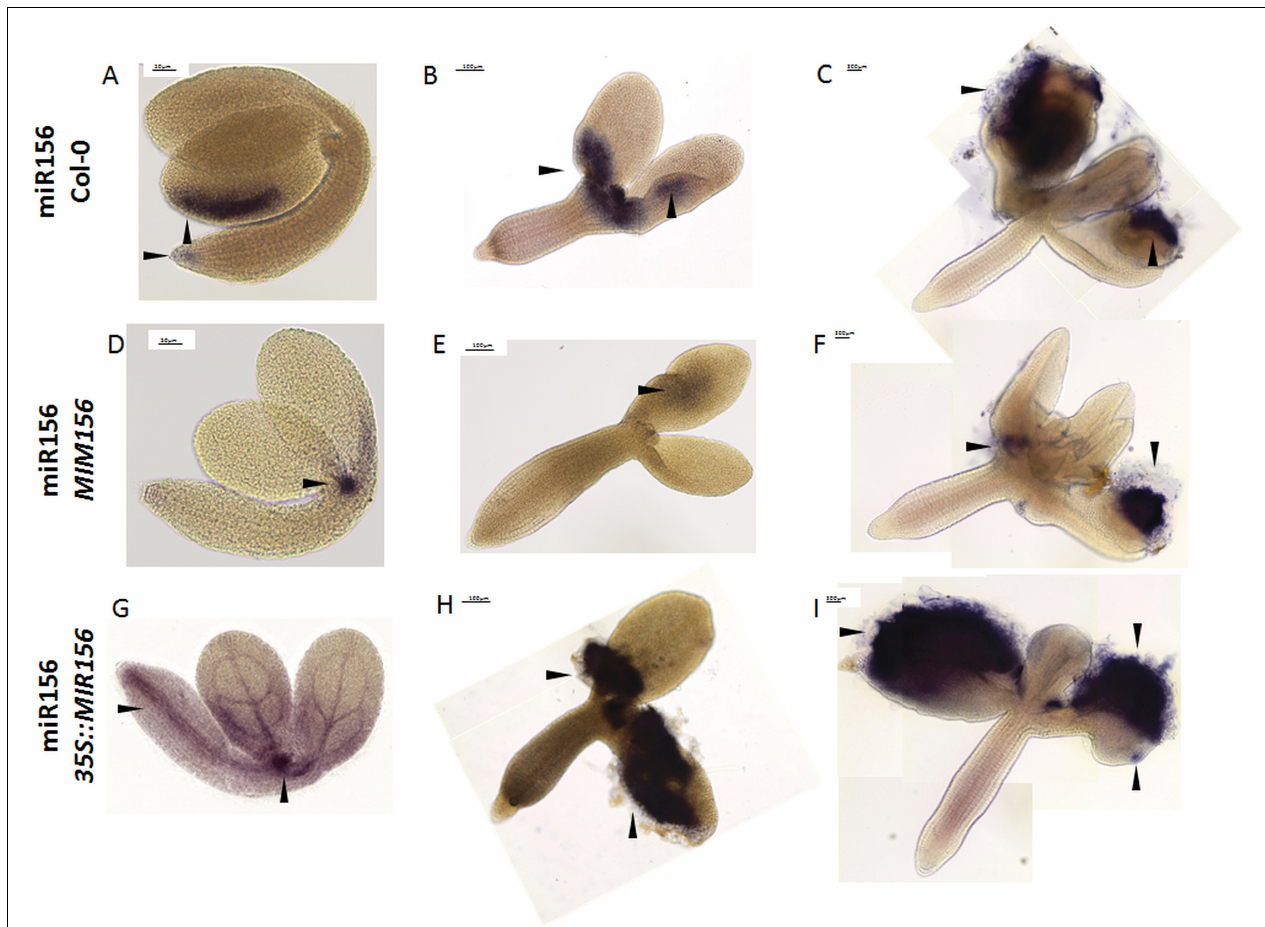
FIGURE 4 | Whole mount in situ hybridization of the miR156 molecules in the explants undergoing SE induction in WT (A–C) , MIM156 (D–F) , and 35S::MIR156 (G–I) at 0th day (A,D,G) , 5th day (B,E,H) , and 10th day (C,F,I) . Arrow heads indicate the detected